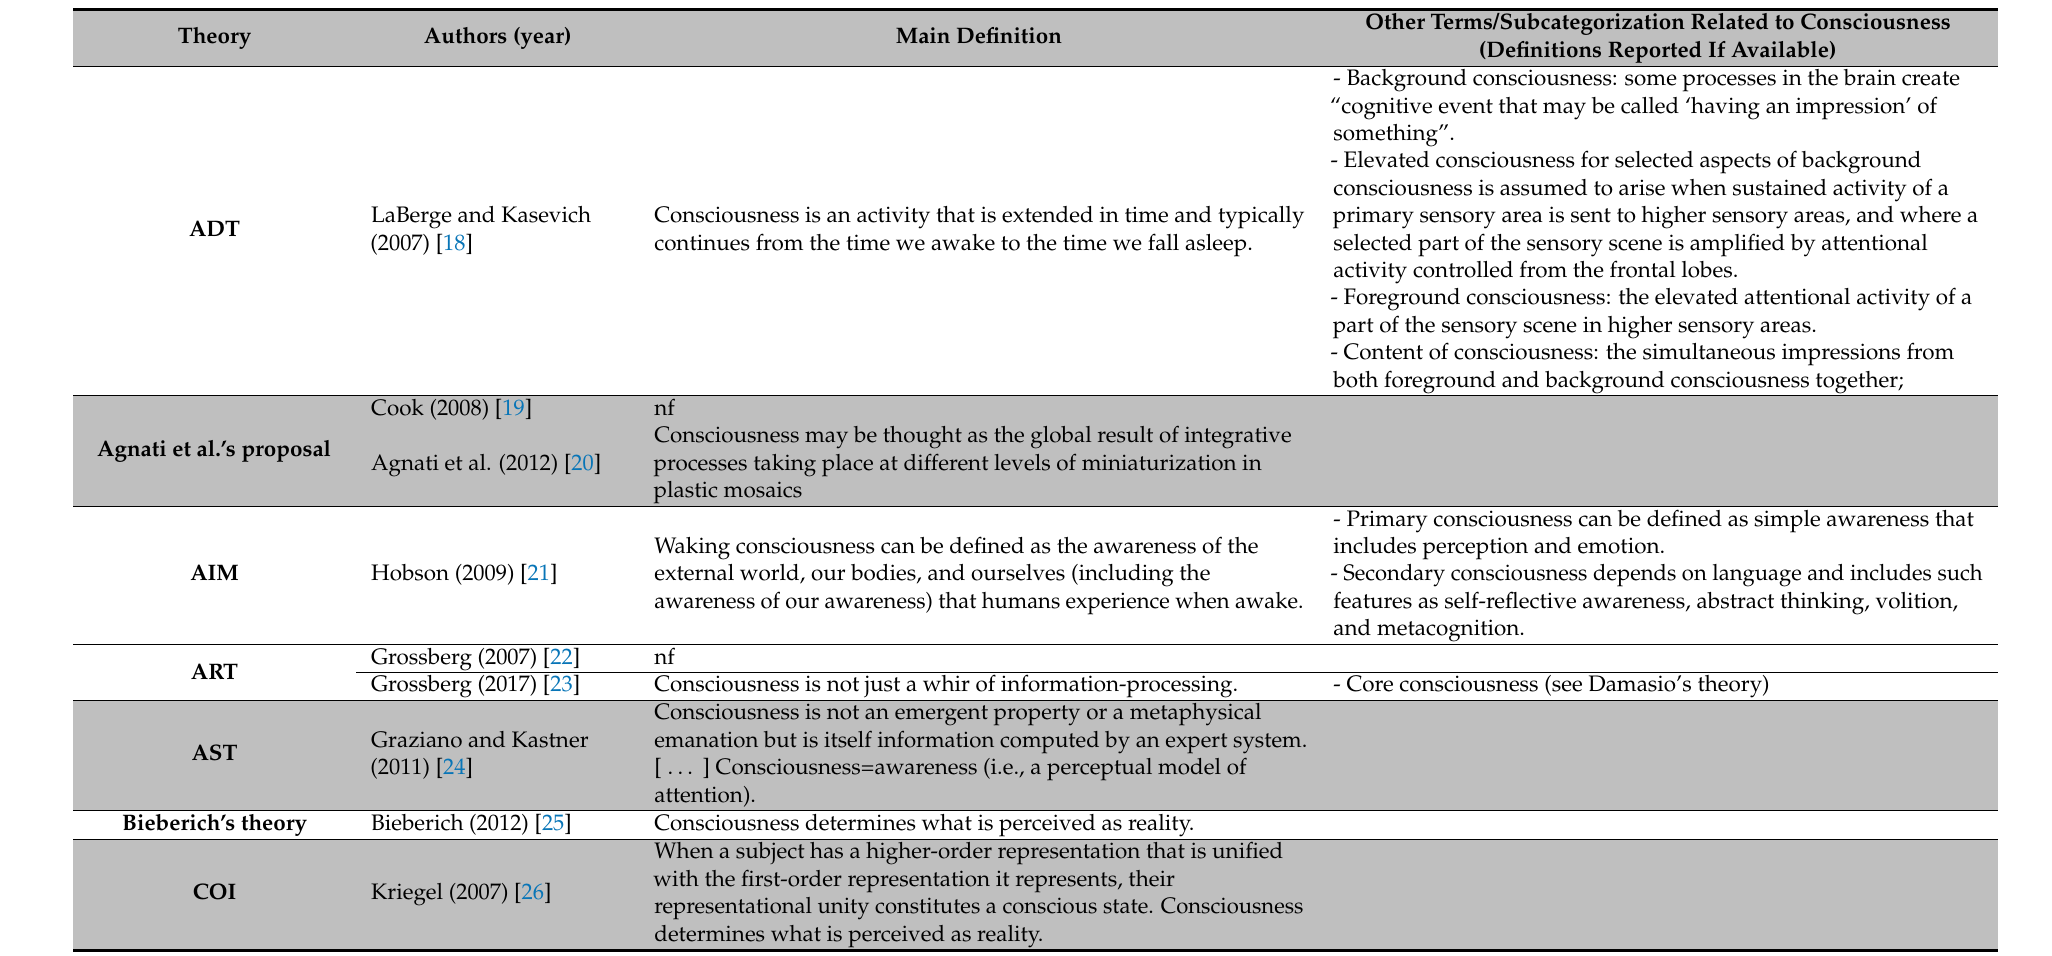
Table 1. Consciousness definitions found in the collected